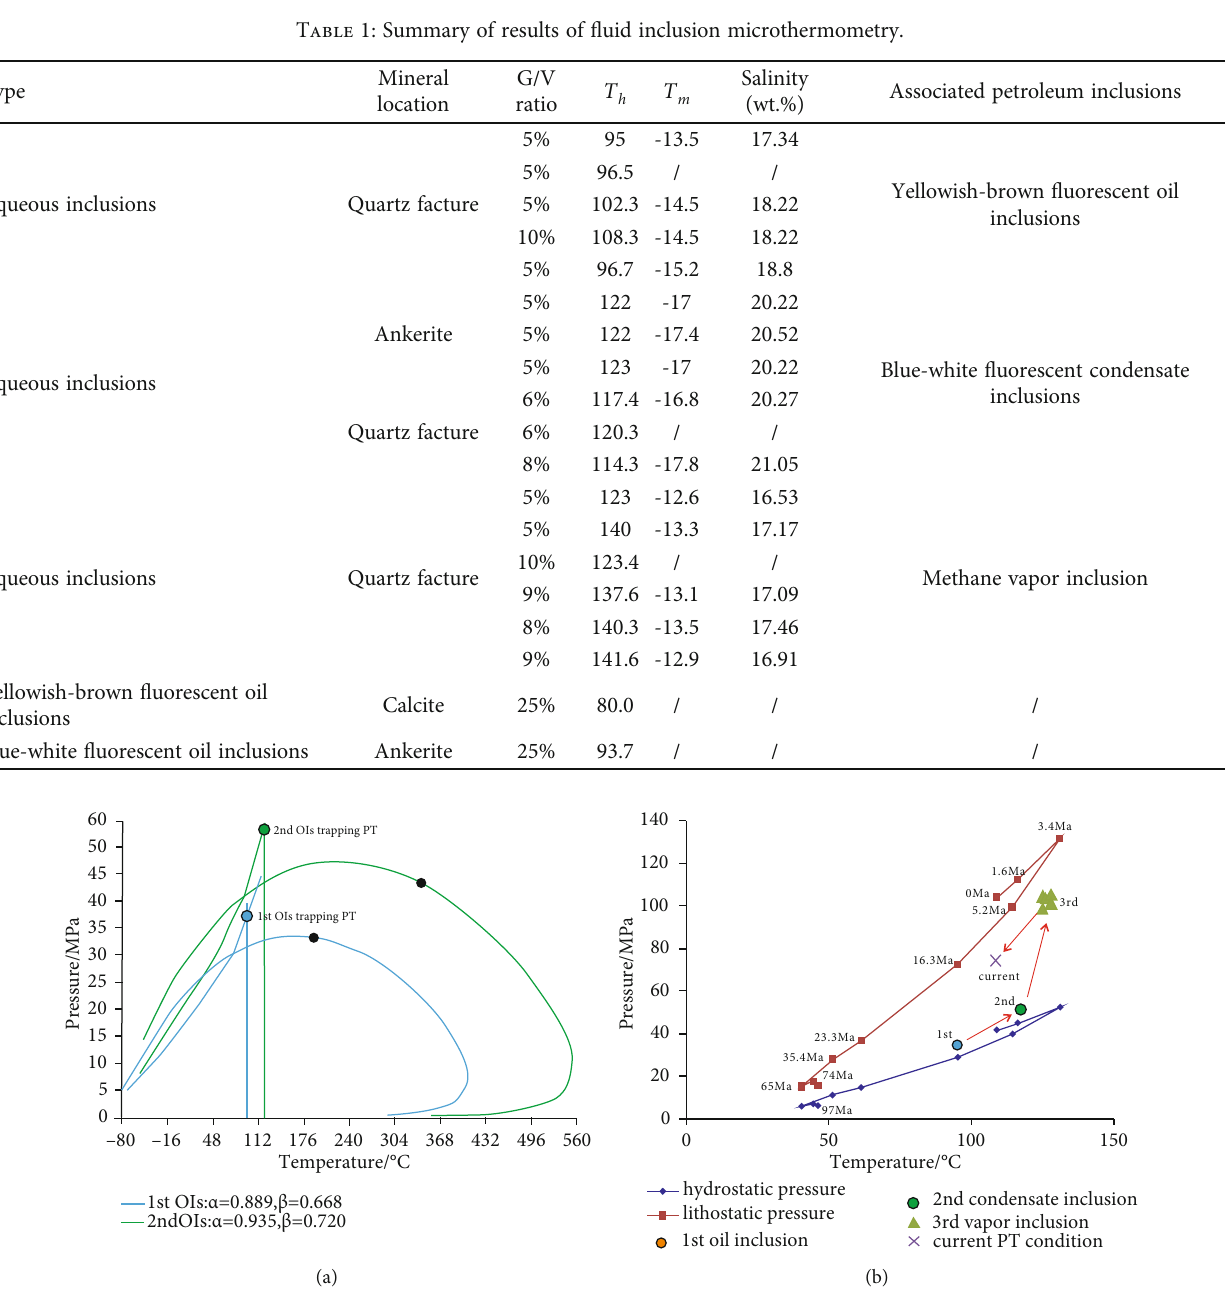
Figure 4: Pressure and temperature evolution of the K1bs sandstone in well KL201, according to fl uid inclusion PVT simulation. (a) Results of PVT simulation for determining the trapping pressure and temperature conditions of the oil inclusions (OIs) of groups 1 and 2. (b) Pressure and temperature evolution of the K1bs sandstone in well KL201, showing the evolution from OIs of group 1, to condensate inclusions of group 2, to vapor inclusions of group 3, and the current pressure and temperature